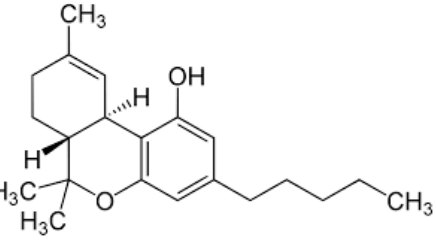
Physiological effect: β 2 adrenoreceptor agonist [44]. It distorts the user’s perception Figure 37. Chemical structure of tetrahidrocannabinol. Formula: C 21 H 30 O 2 . Figure 37. Chemical structure of tetrahidrocannabinol. Formula: C 21 H 30 O 2.